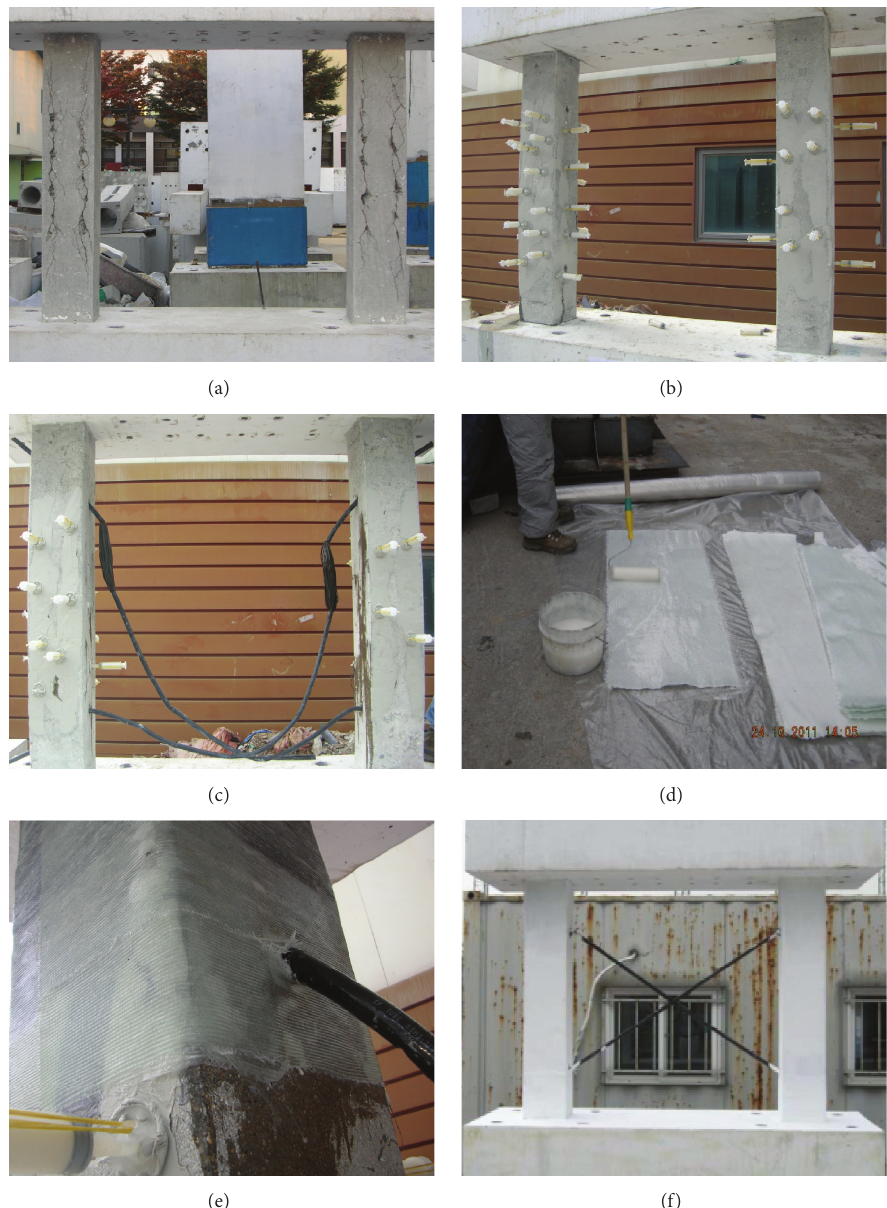
Figure 4: The fabrication procedure. (a) Control specimen with class-V damage, (b) surface treatment and injection of epoxy resin into the crack, (c) drilling of anchoring holes and installation of the CF X-bracing, (d) primer treatment process of the GF sheet, (e) externally bonded GF sheet wrapping, and (f) a specimen strengthened using the hybrid CF X-bracing and GF sheet wrapping